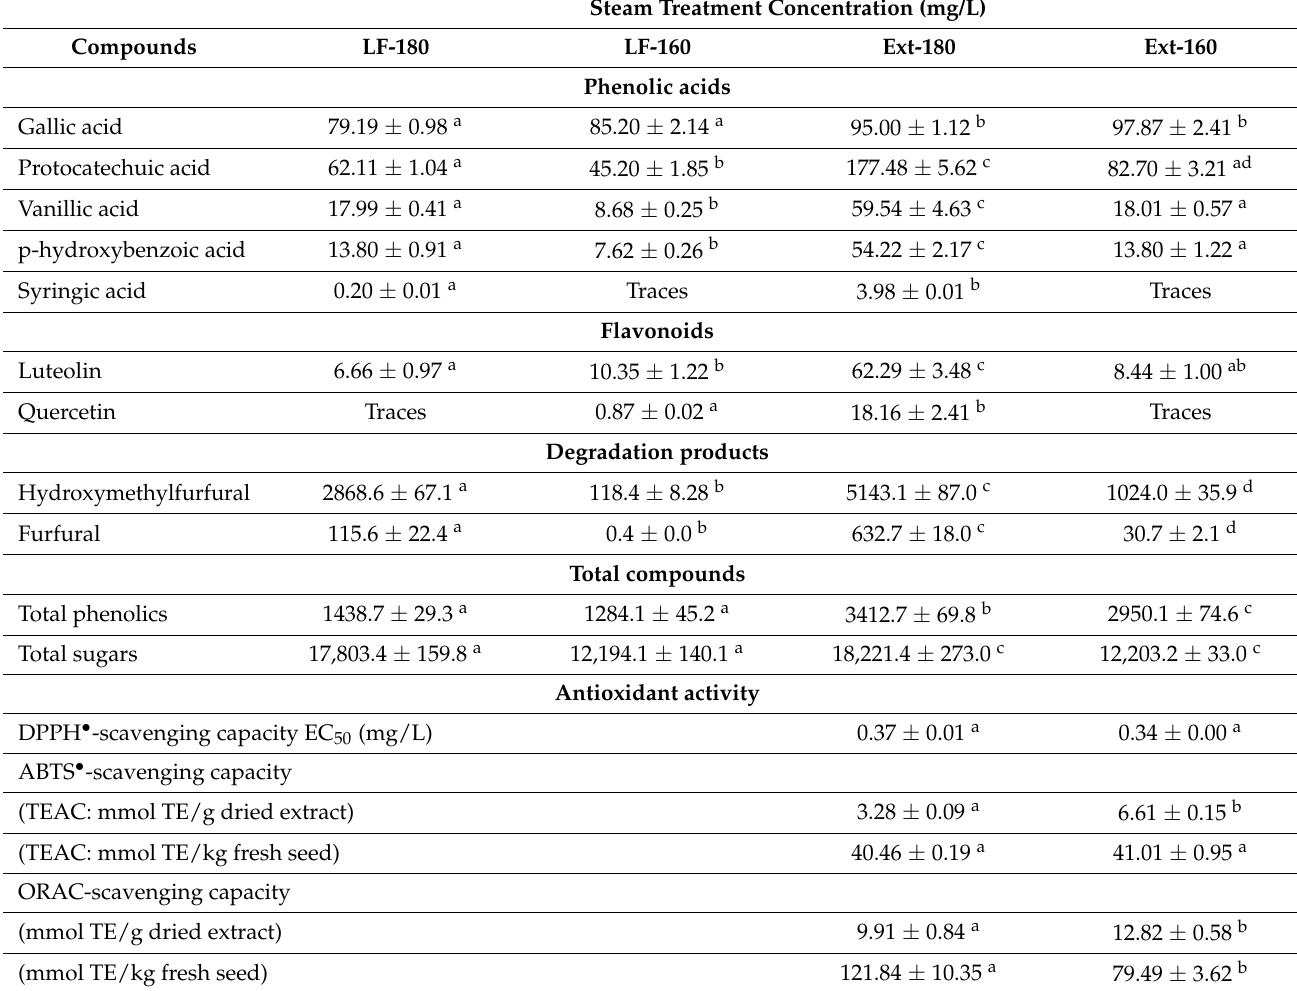
Table 2. Composition of acid phenols, flavonoids, sugar degradation products, phenols, and total sugars and antioxidant activity of date seed liquid fractions treated at 160 and 180 ◦ C for 60 min and their respective extracts obtained chromatographically. Values are mean ± SD. Different letters indicate significantly different results ( p <